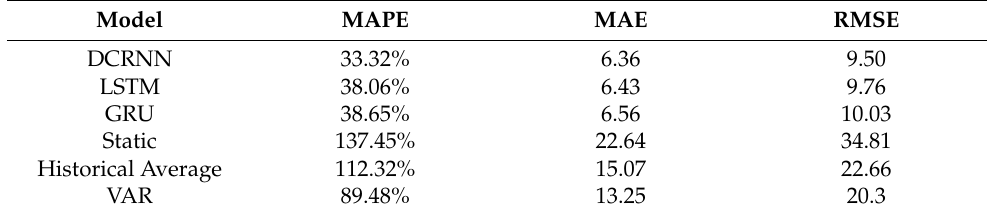
Table 3. Model comparison